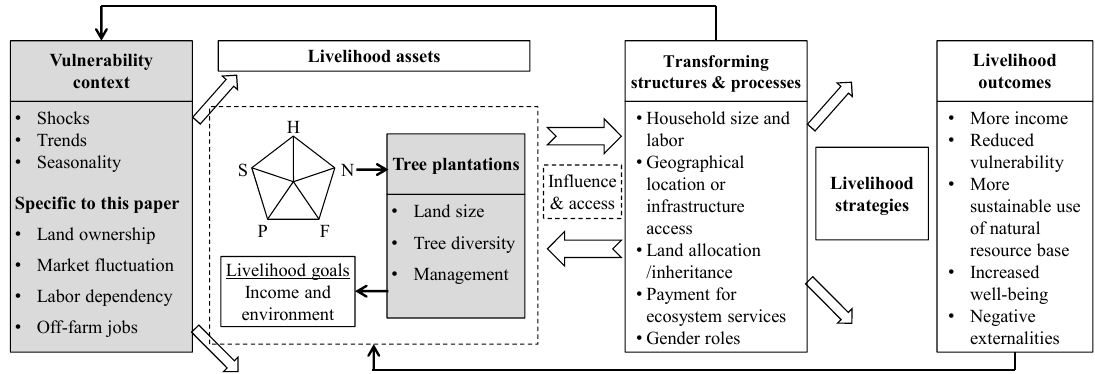
Figure 1. A livelihood framework with tree plantations. Source: adapted from Department of International Development (DFID) [37]. Note: H = Human Capital; N = Natural Capital; F = Financial Capital; P = Physical Capital; S = Social Capital.